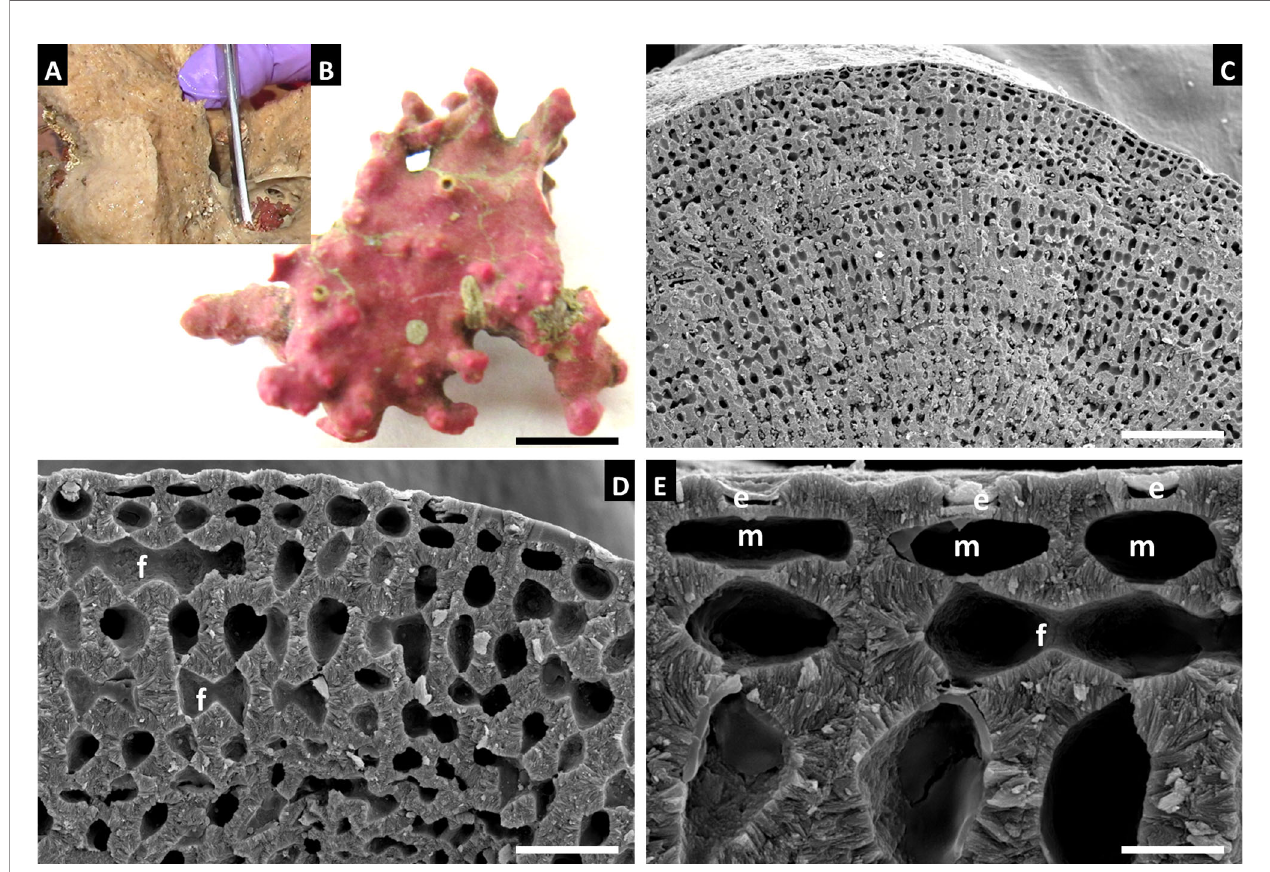
FIGURE 6 | Sporolithon sinusmexicanum , voucher no. LAF 7255 (A-E). (A) Thallus habit in situ growing inside of a marine sponge. (B) Thallus habit. Scale bar = 0.4 cm. (C) Longitudinal section of rhodolith protuberance. Scale bar = 110 µm (D) Magni fi ed view of longitudinal section of protuberance showing cell fusions between perithallial cells (f). Scale bar = 25 µm (E) Magni fi ed view of epithallial cells (e), some with intact epithallial cell roofs, intercalary meristematic cells (m), and cell fusions between perithallial cells (f) Scale bar = 7